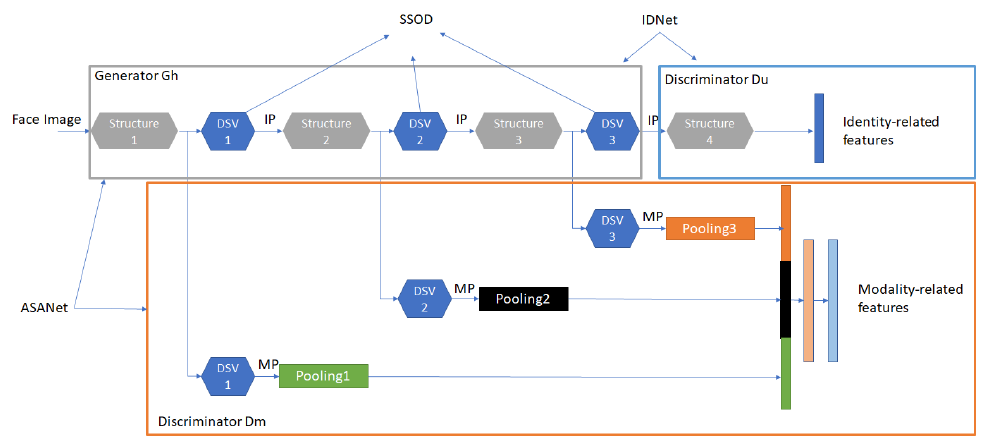
Figure 9. An illustration of the proposed DSVNs architecture based on